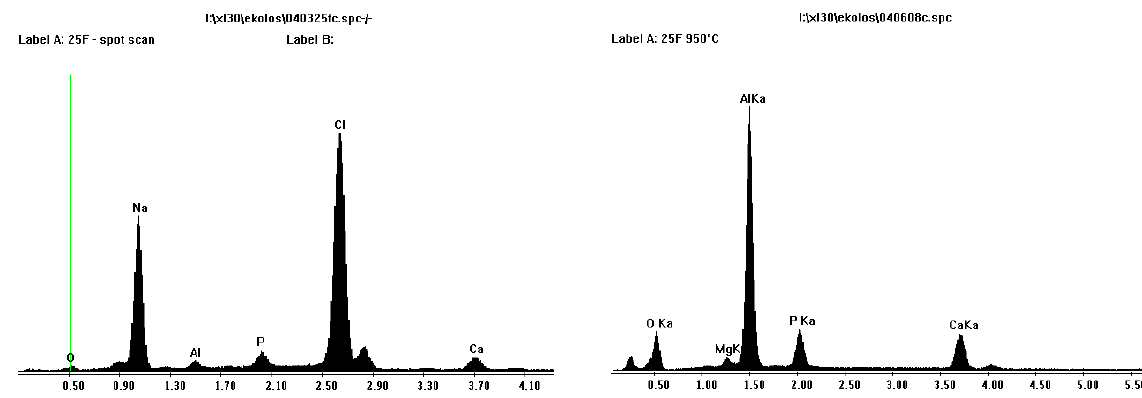
Figure 9. SEM and EDS of before ( left ) and after ( right ) heat treatment of coating at 950 °C for less porous Sample B alumina. Sodium and chlorine are no longer present after heat treatment.